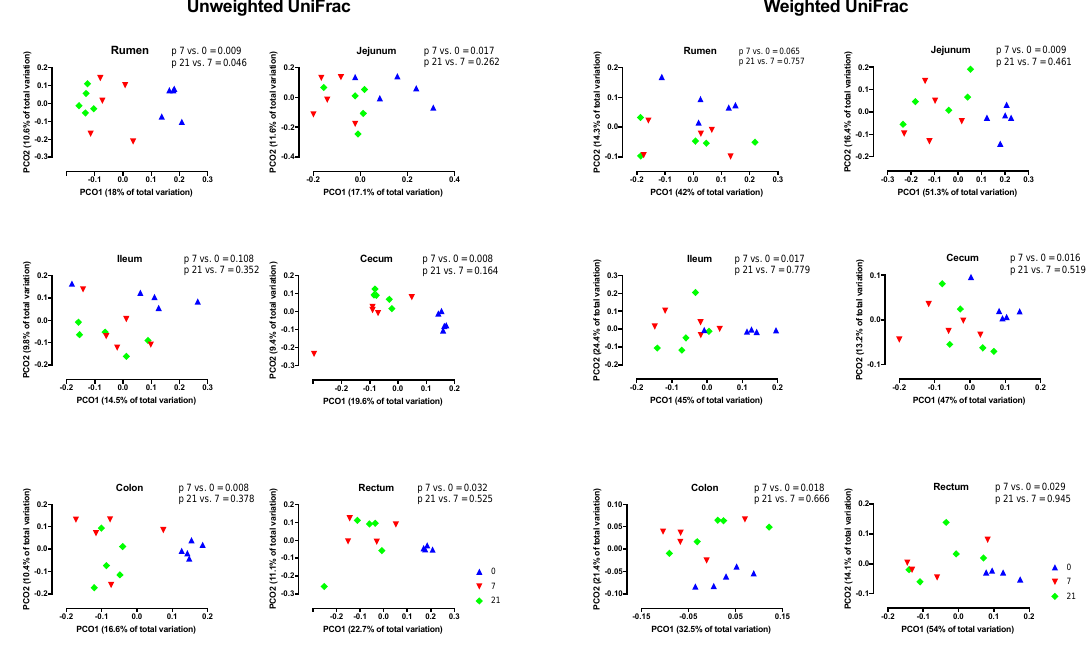
Figure 4. Principal coordinate analyses (PCoA) of unweighted and weighted UniFrac distances of treatments by region of the digestive tract. Day 0 = no grain feeding, Day 7 = moderate grain feeding for 7 d, Day 21 = moderate grain feeding for 21 d.